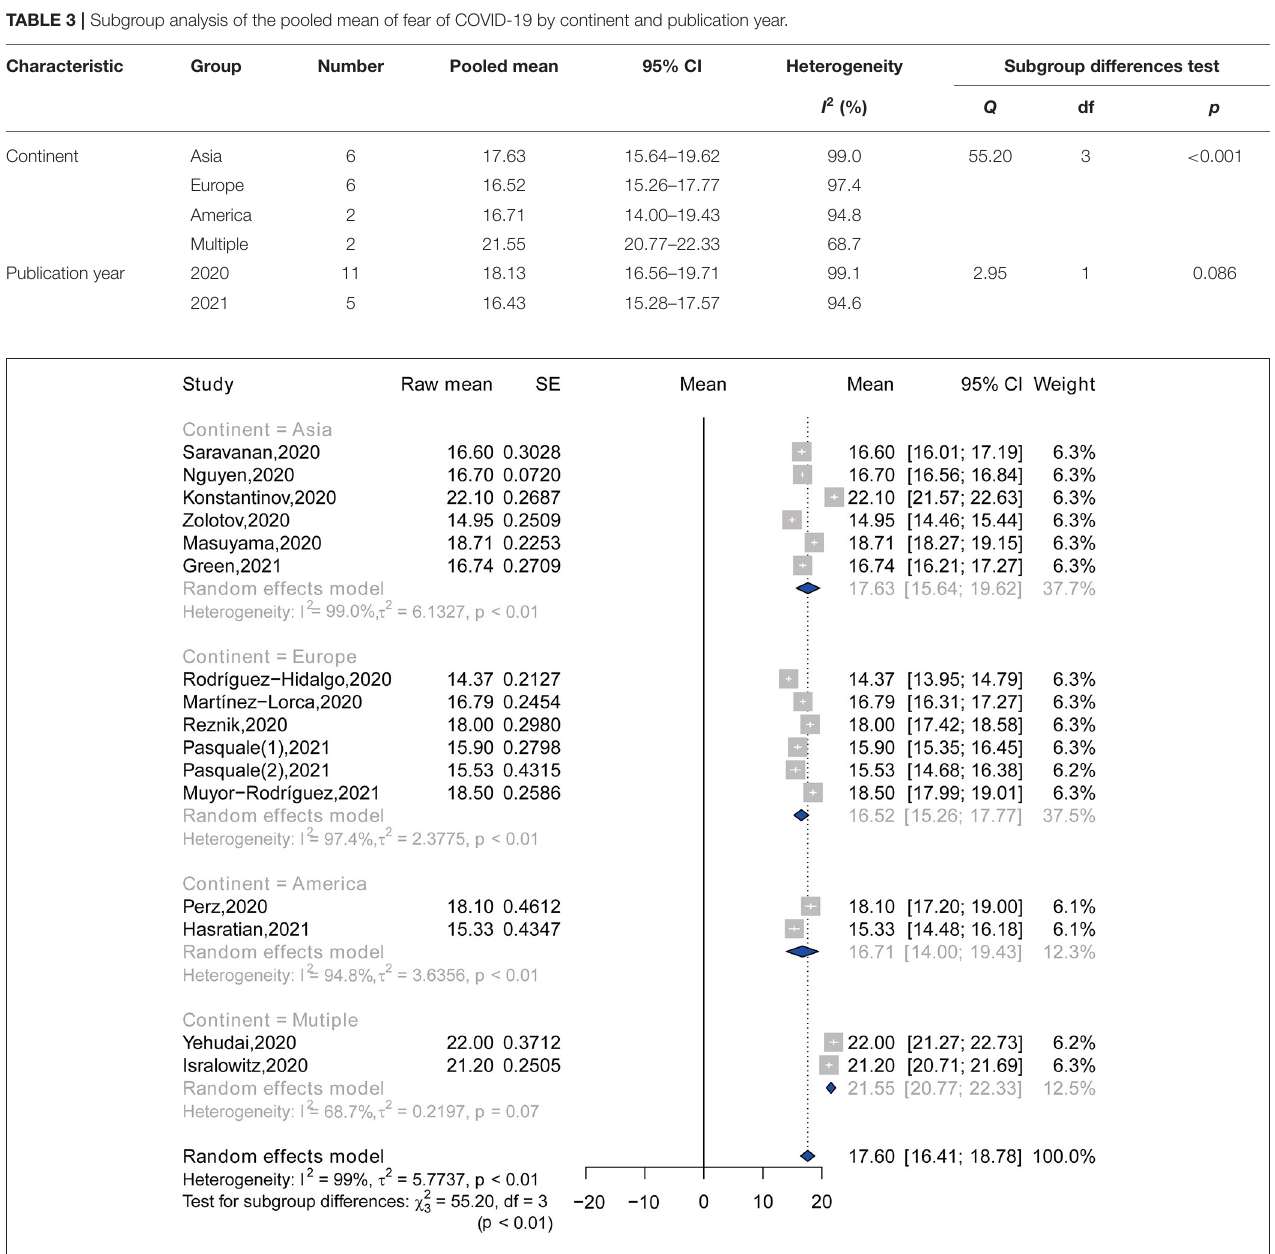
FIGURE 3 | Forest plot of the total mean score of fear, according to